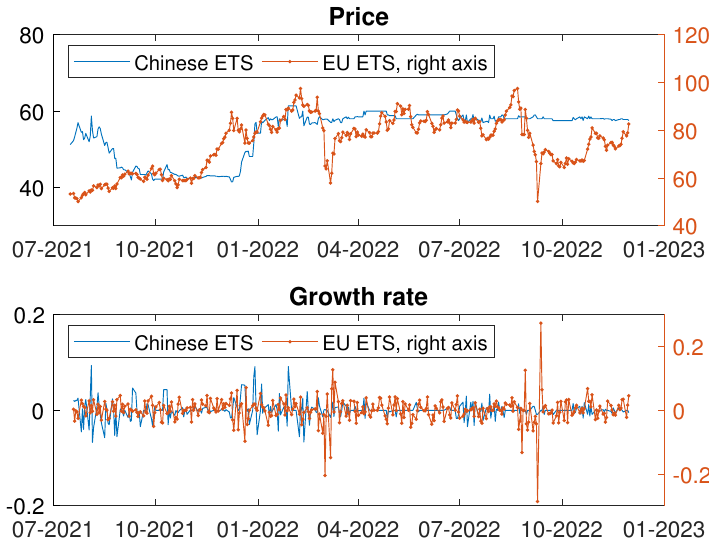
Figure 1. Prices and price growth rates of the Chinese ETS (emission trading system) and EU ETS. Note that the price units for the Chinese and EU ETS are RMB and Euro,